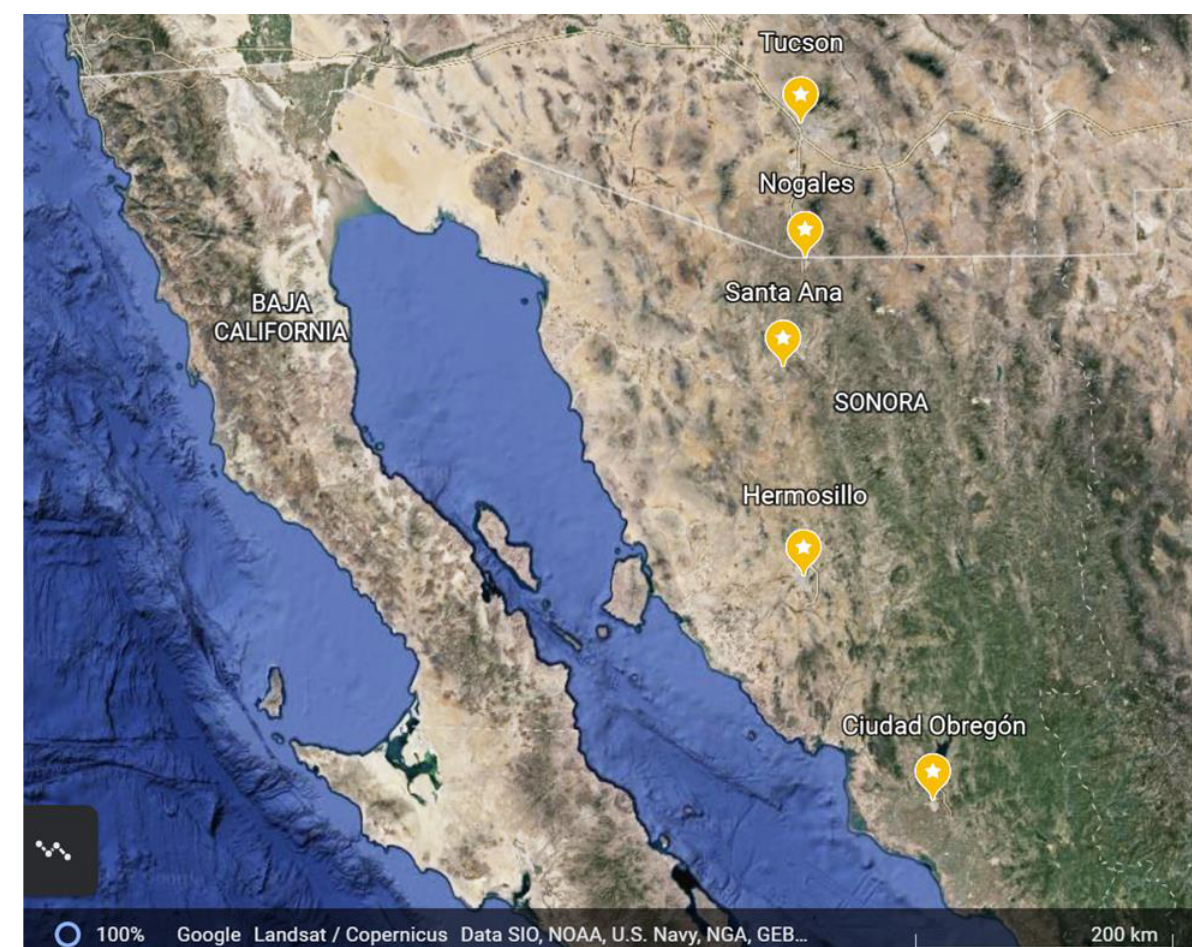
Figure 1. Map of study cities in the Arizona-Sonora Desert region from Arizona (USA) to Sonora (Mexico). Table 1. Climate averages among study site cities.